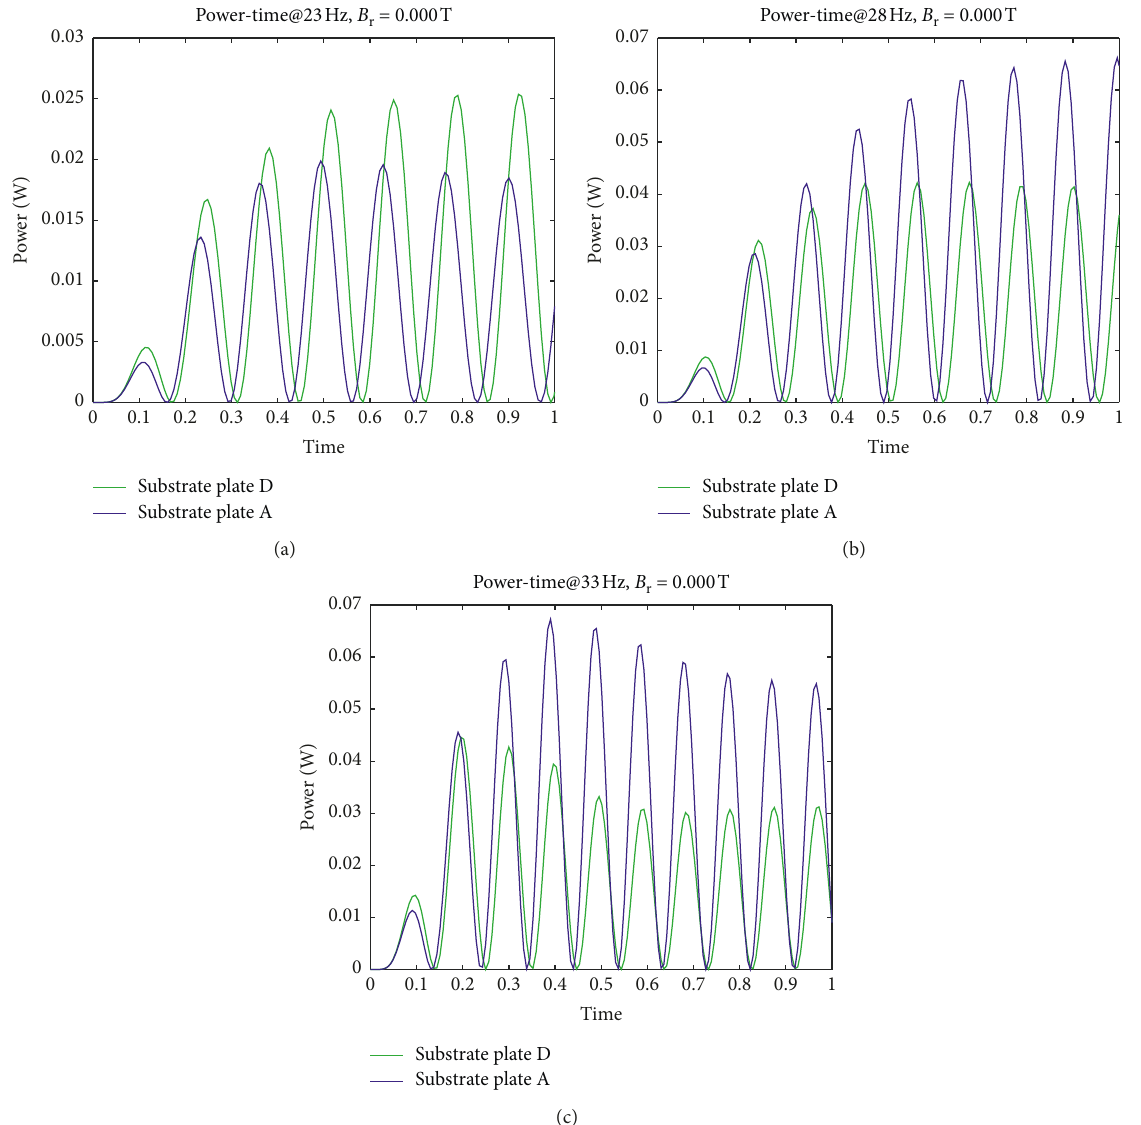
Figure 9: Power output in time history for the linear EMM system: (a) 23Hz; (b) 28Hz; (c)